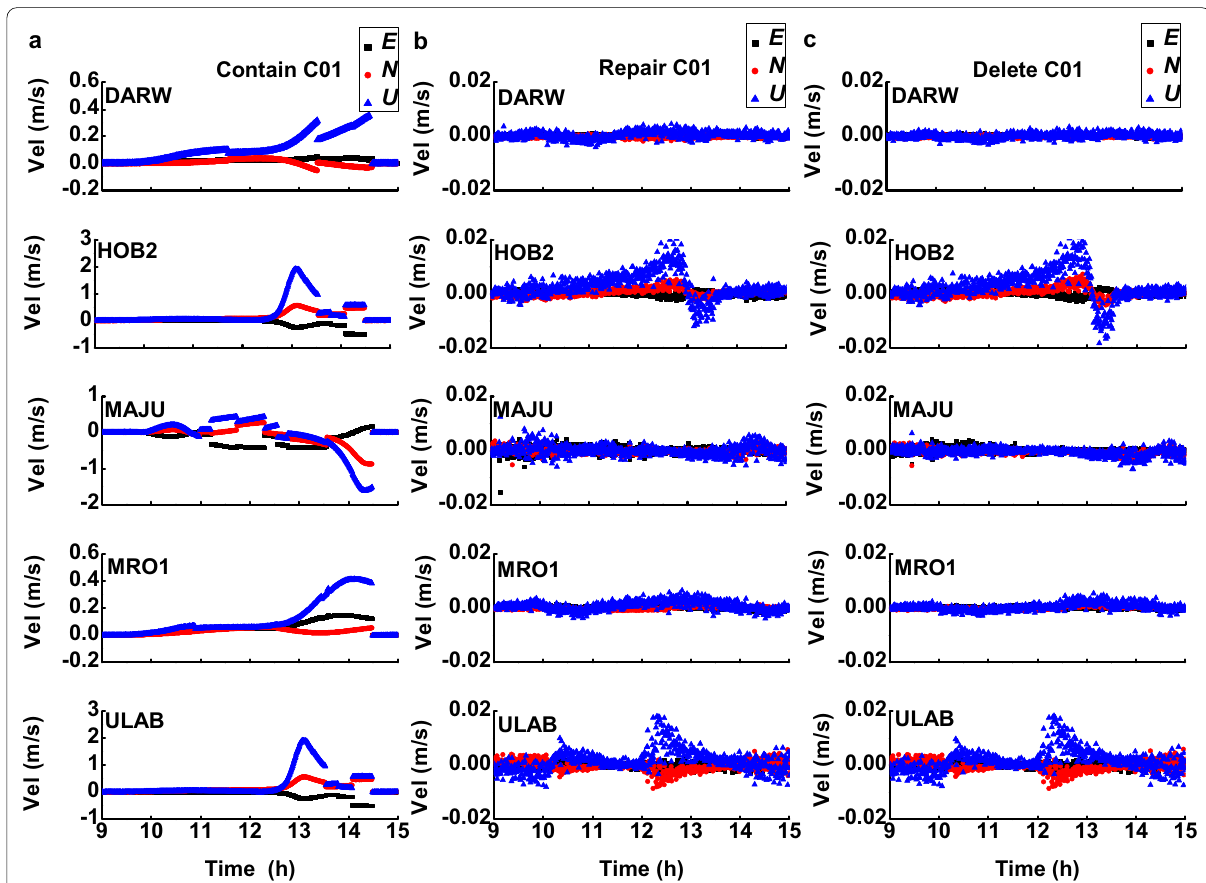
Fig. 5 Comparison of biases for the estimated velocity with the data from the maneuvering satellite included a , and with the orbital error of the maneuvering satellite corrected b or with the data from the maneuvering satellite deleted c . From top to bottom, the plots are for stations DARW, HOB2, MAJU, MRO1, and ULAB. The black, red, and green colors represent east, north, and up components,